Question: State the chart type depicted above.
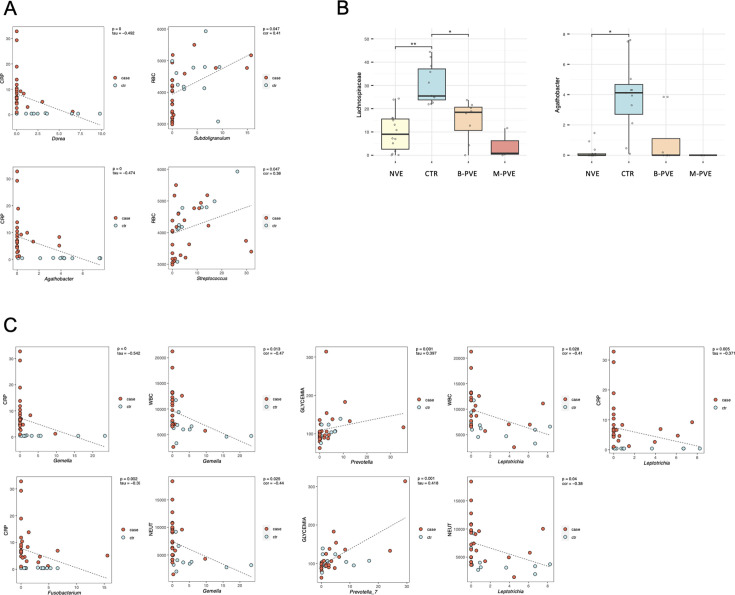
Answer: scatter